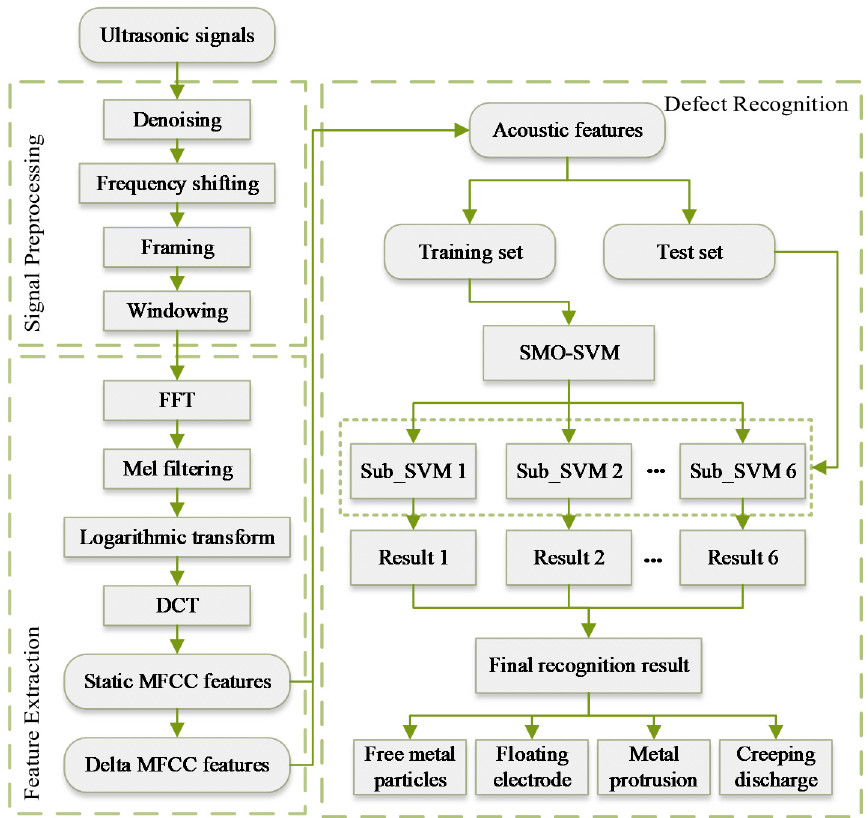
Figure 2. The flowchart for constructing the voiceprint recognition system for insulation defects identification of gas-insulated switchgear (GIS).